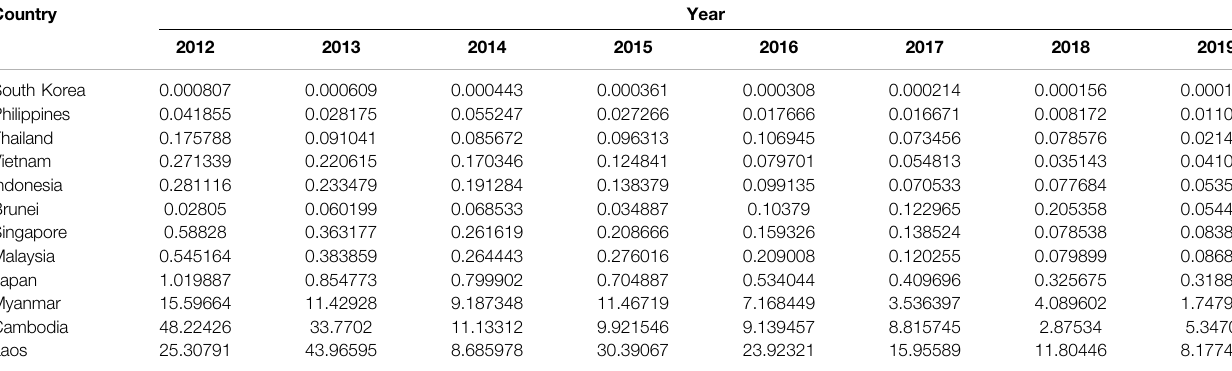
TABLE 9 | Time trend of the export ef fi ciency values of China ’ s WETC exports to ASEAN plus Japan and South Korea.